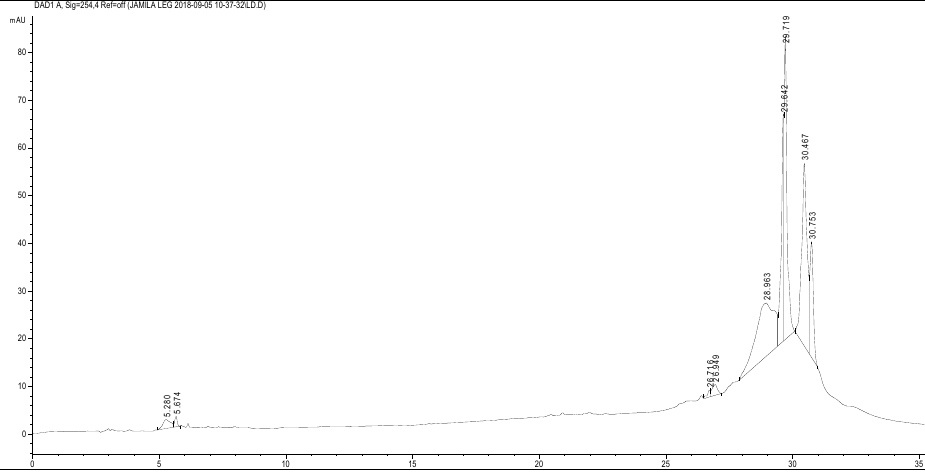
Table 2. Total polyphenol content and antioxidant activity of methanolic extract of M. vulgare reported in different